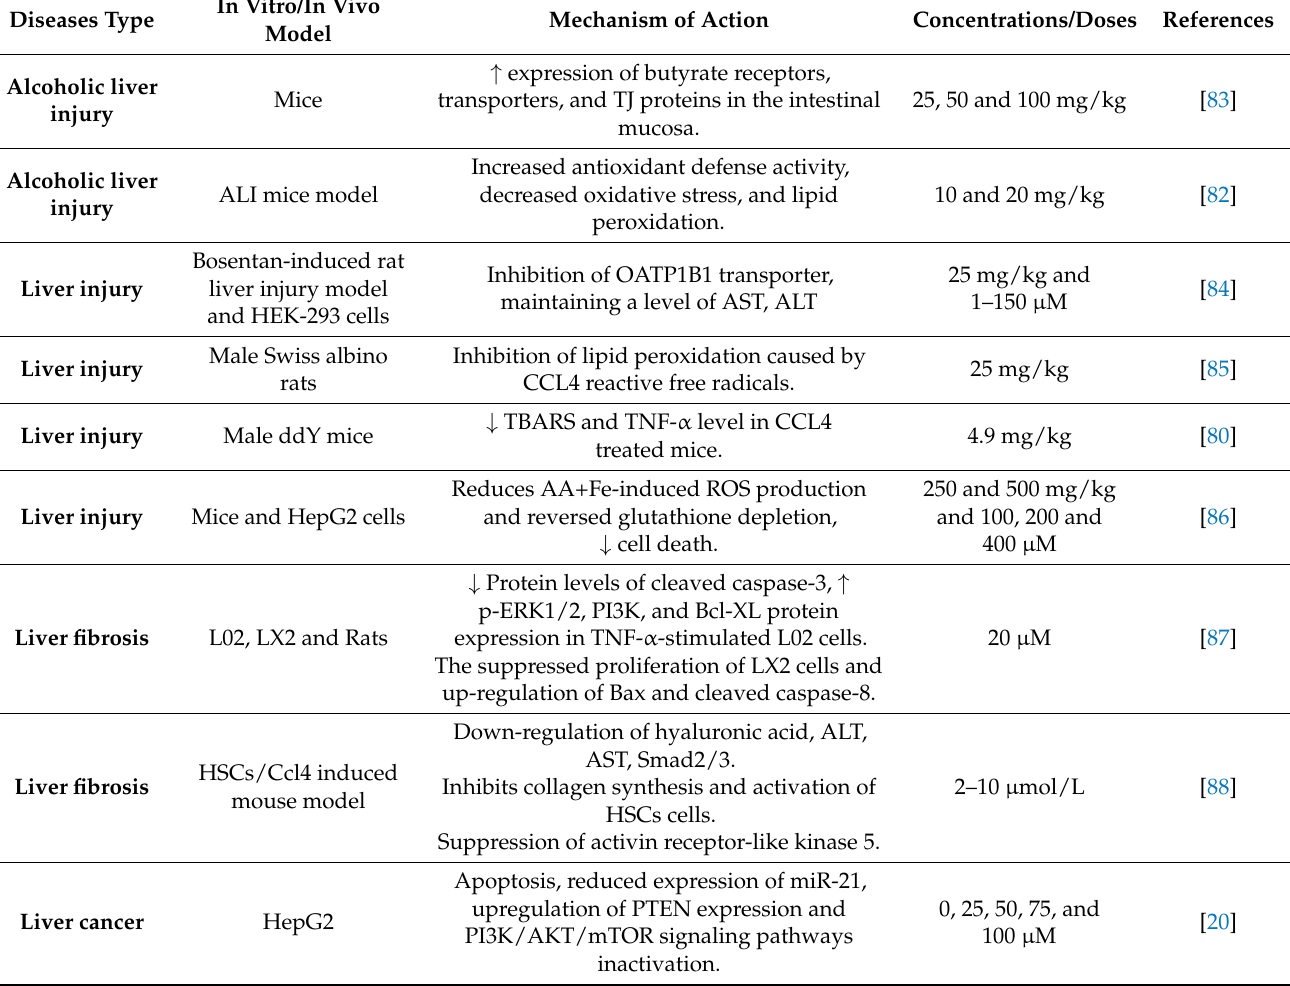
Table 2. The role of kaempferol in alleviating liver